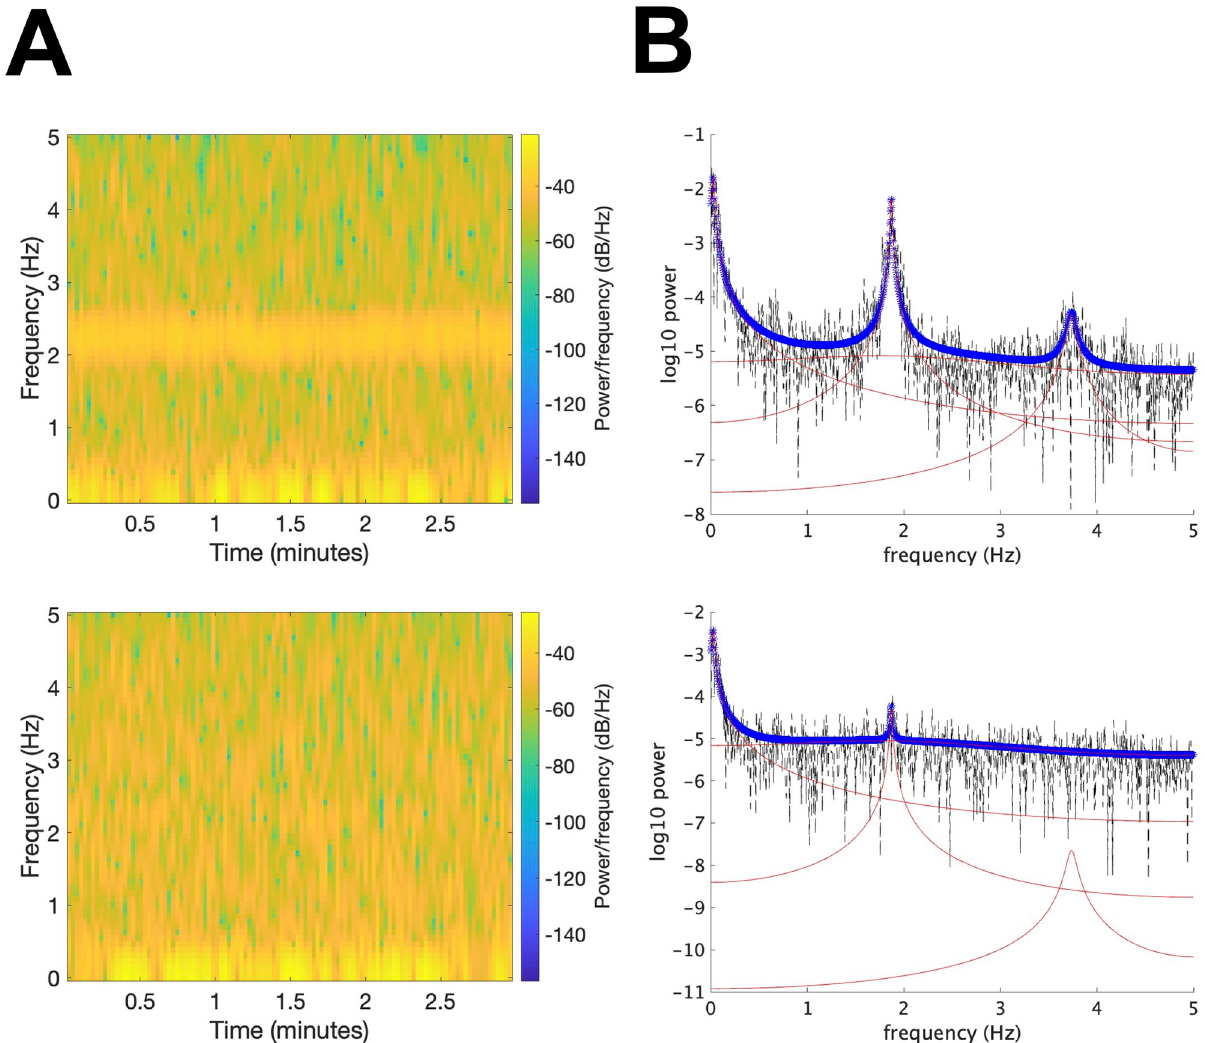
Fig 10. (A) Spectrogram of infant fNIRS data in Fig 8. Upper: oxy-Hb; lower: deoxy-Hb. (B) Periodogram (black), spectral density functions of the fitted oscillators (red) and their sum (blue) for infant fNIRS data in Fig 8. Upper: oxy-Hb; lower: deoxy-Hb.